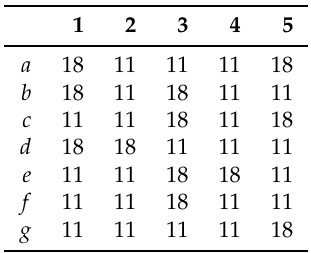
Table 1. Scores of seven students on five subjects.